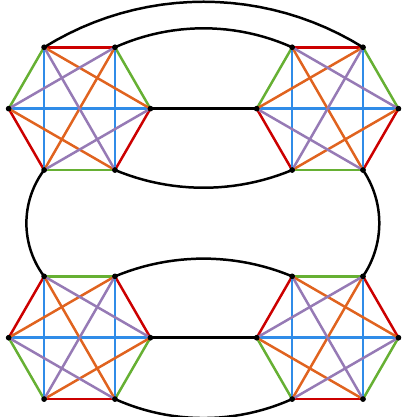
Figure 7. Feynman diagram consisting in a ladder with two rungs and complete vertices. Its external tensor contractions are equivalent to J 2 (the